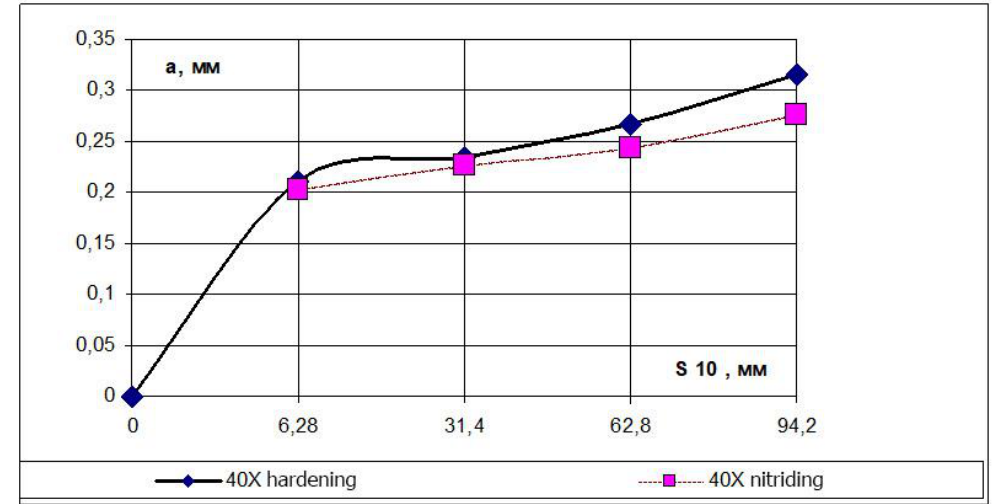
Fig. 4. Graphs of the dependence of the dimensions of the equivalent radius of the contact spot on the friction path